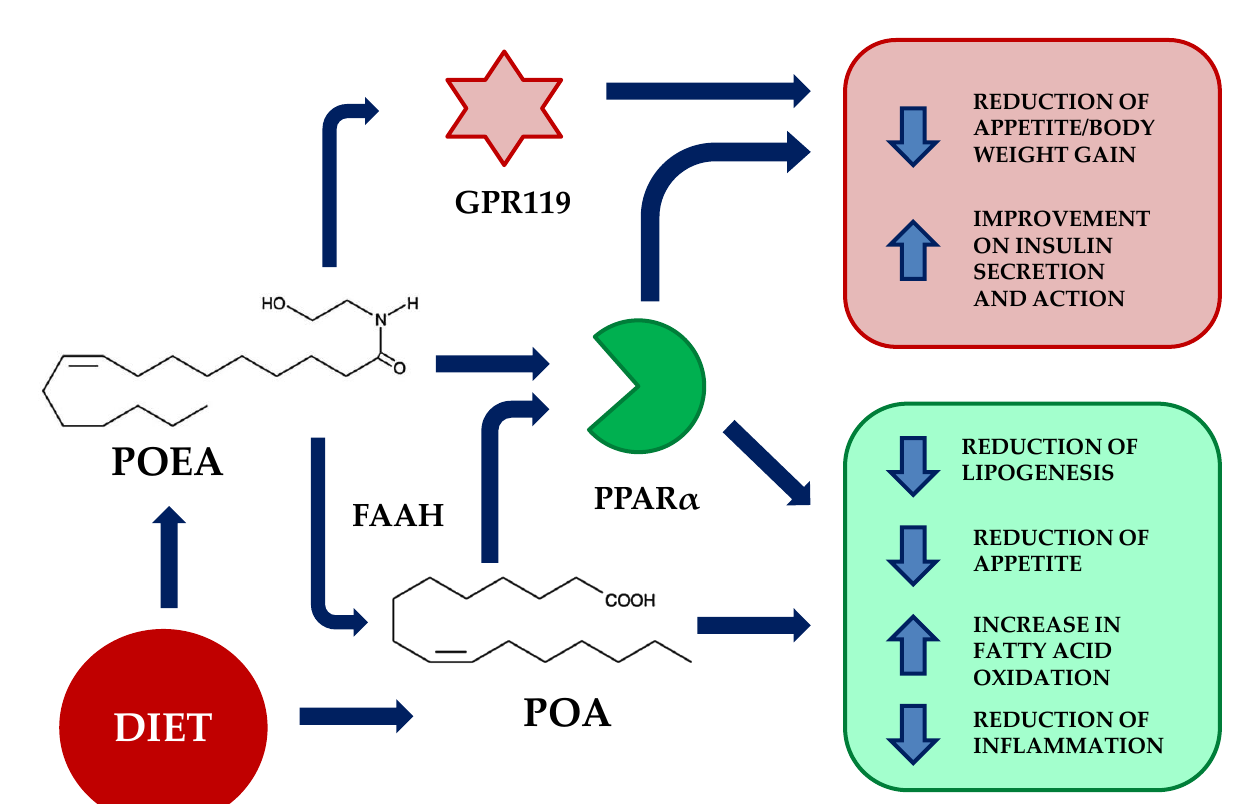
Figure 1. Potential mechanisms of action of palmitoleylethanolamide (POEA). POEA is the N-acylethanolamine of palmitoleic acid (POA). Upon dietetic administration, POEA might act directly through peroxisome proliferator-activated receptor alpha (PPAR- α) receptors, promoting the inhibition of lipogenesis, reduction of appetite, increase in fatty acid oxidation, and reduction of inflammation. These actions are also mimicked by palmitoleic acid, its main degradation product. In addition, POEA has been found to activate the orphan G protein-coupled receptor 119 (GPR119), resulting in a reduction of appetite and improvement of insulin action. FAAH; fatty acid amide hydrolase.